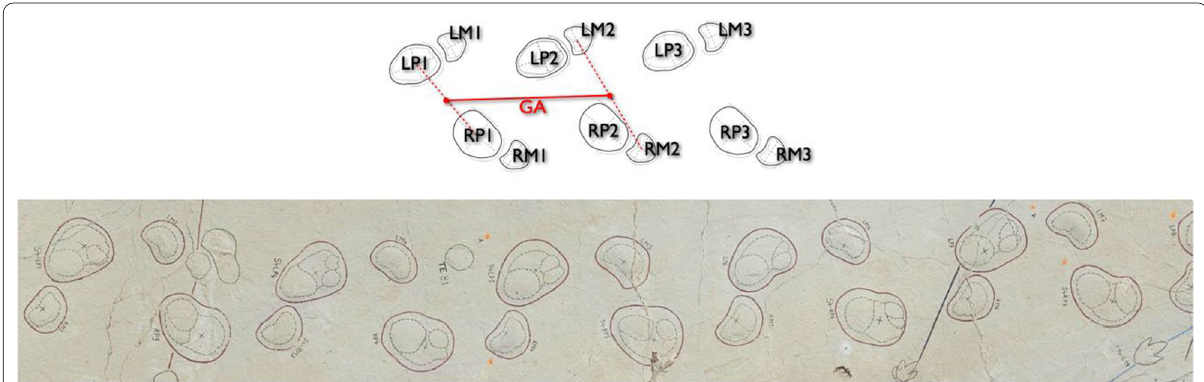
Fig. 1 In the conventional practice of quadrupedal trackmaker size estimation, a line segment is constructed between two pes tracks (LP1 and RP1, above) and another between two manus tracks (LM2 and RM2). The separation GA between the centers of these two line segments is often used as the basis for estimating the trackmaker’s gleno-acetabular distance D GA , subject to a correction to account for the presumed gait (see text), and having selected the correct pair of manus tracks to associate with the given pair of pes tracks. Perhaps contrary to intuition, an exquisitely preserved and regular trackway such as BEB-500-S4 (lower), one of the trackways used in this study, could have been created by a quadruped of many possible sizes and many possible